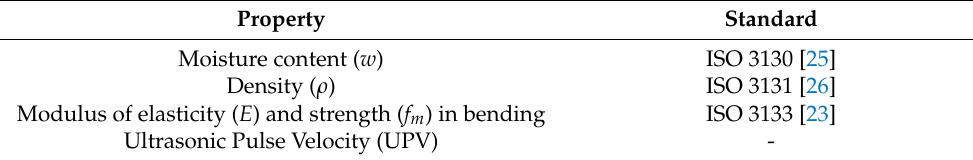
Table 1. Reference standards for each property evaluated in the experimental